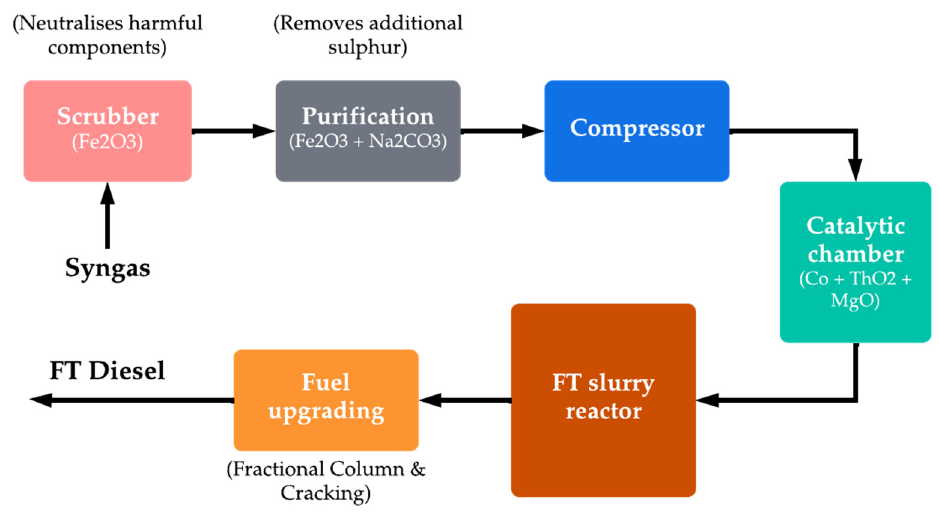
Figure 14. Typical Fischer–Tropsch process for FT diesel production from syngas.